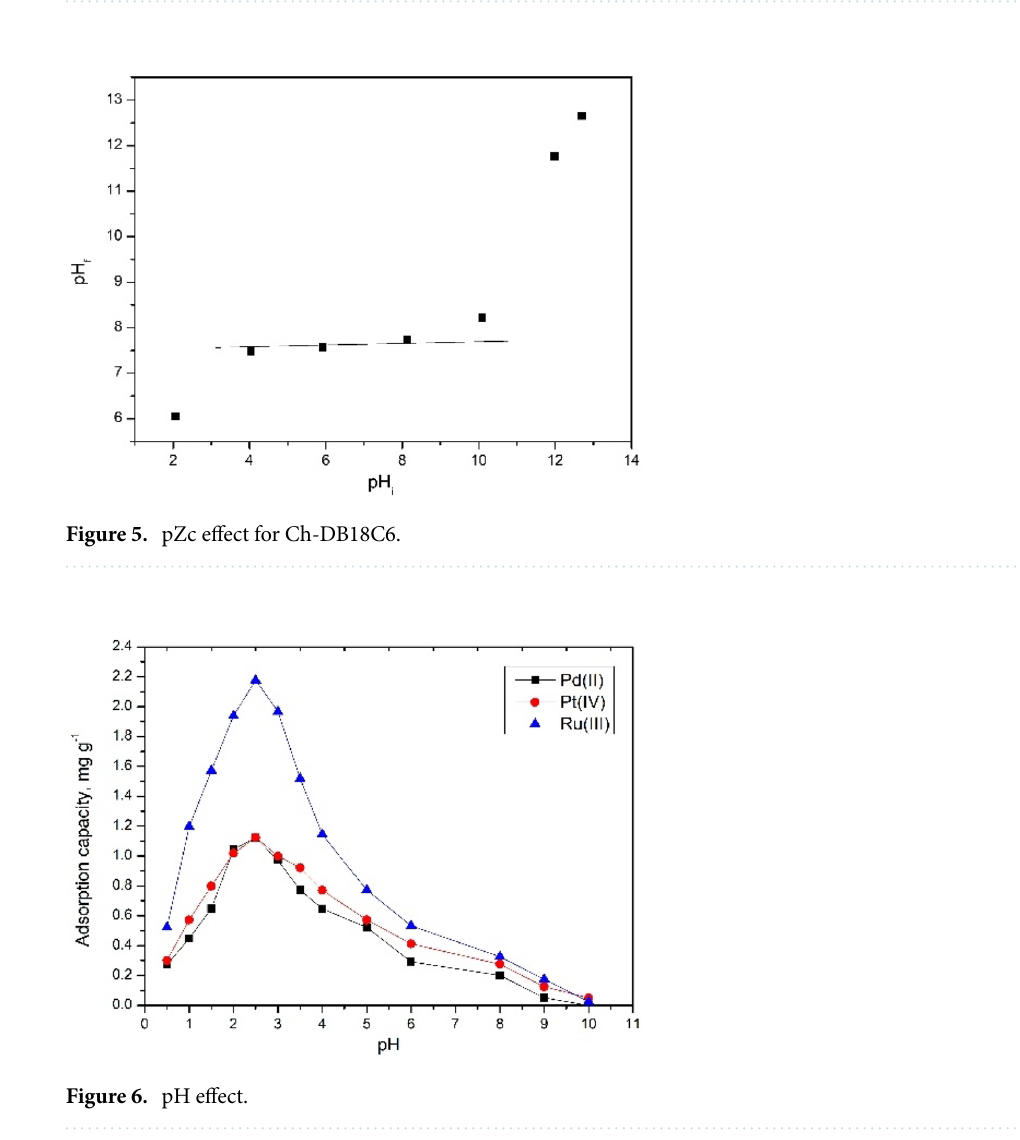
Table 2. Obtained textural parameters.